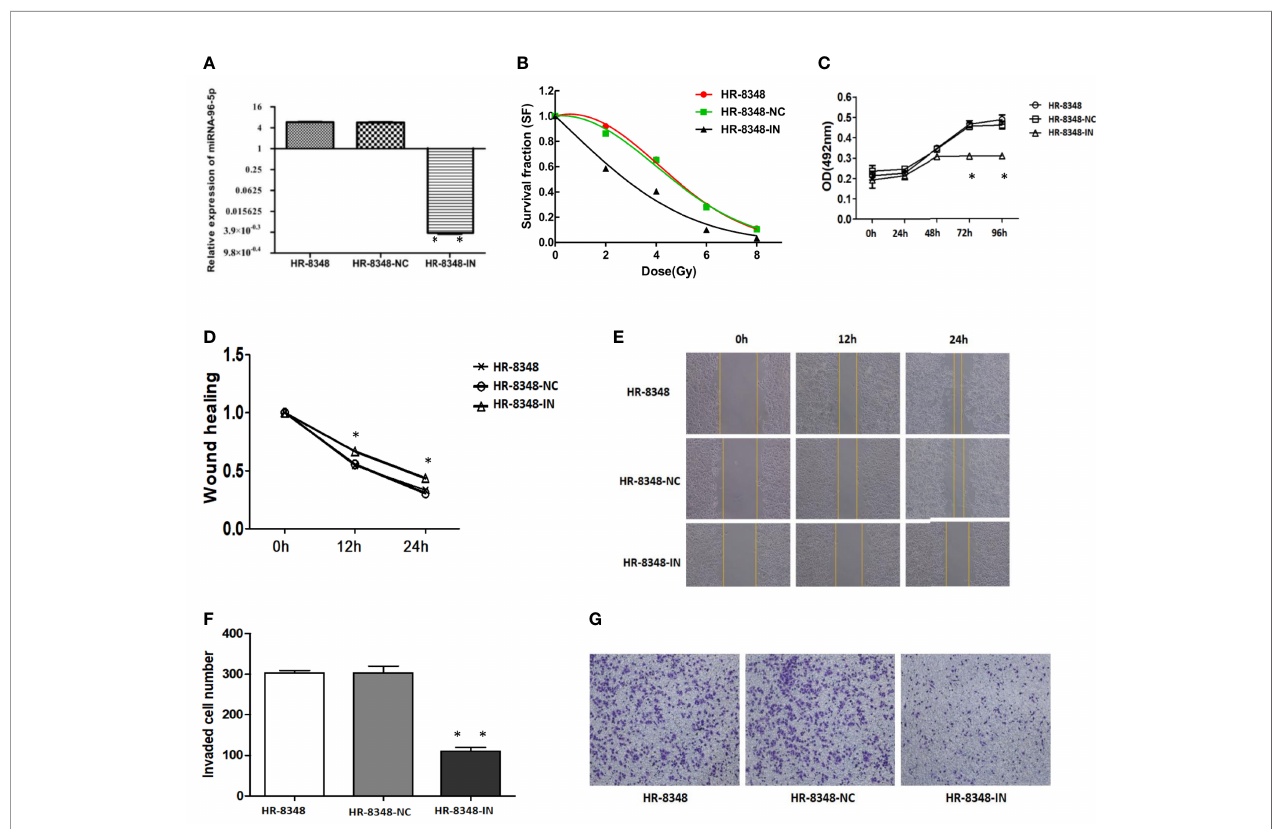
FIGURE 5 | Changes in irradiation reactivity and biological behavior of HR-8348 cells before and after miRNA-96-5p knockdown. (A) MiRNA-96-5p was signi fi cantly down-regulated in HR-8348-IN cells; (B) MiRNA-96-5p low-expression in radio-resistant HR-8348 cells results in increased sensitivity to irradiation, and survival fraction fi tted to the linear quadratic equation; (C) The effect of miRNA-96-5p on rectal cancer cells growth, as measured using the MTS assay; (D – G) The role of miRNA-96-5p in migration and invasion of rectal cancer cells was detected by wound healing test and Transwell assays *P < 0.05, **P <